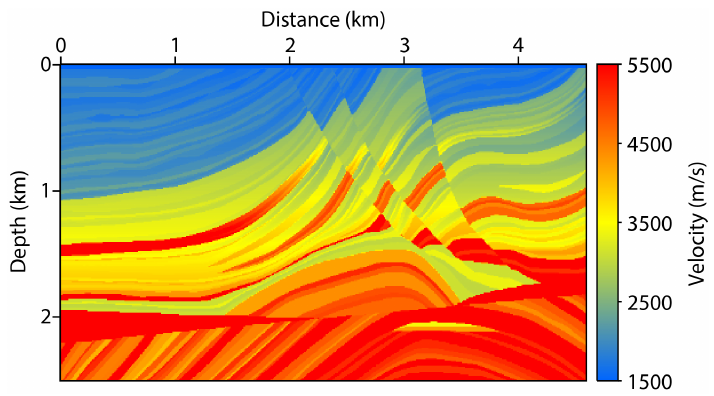
Figure 6. Marmousi model.